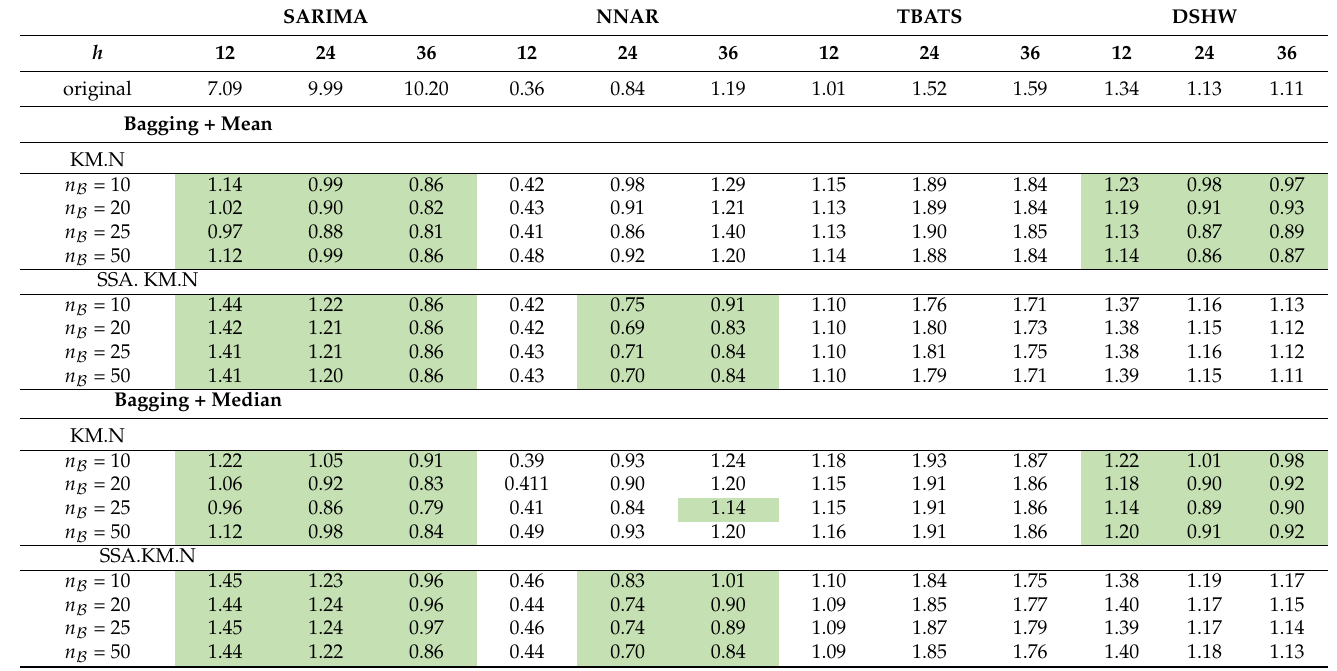
Table 10. MAPEs of h -step ahead forecast for the hourly electricity load of Poland obtained by SARIMA, NNAR, TBATS, and DSHW models.